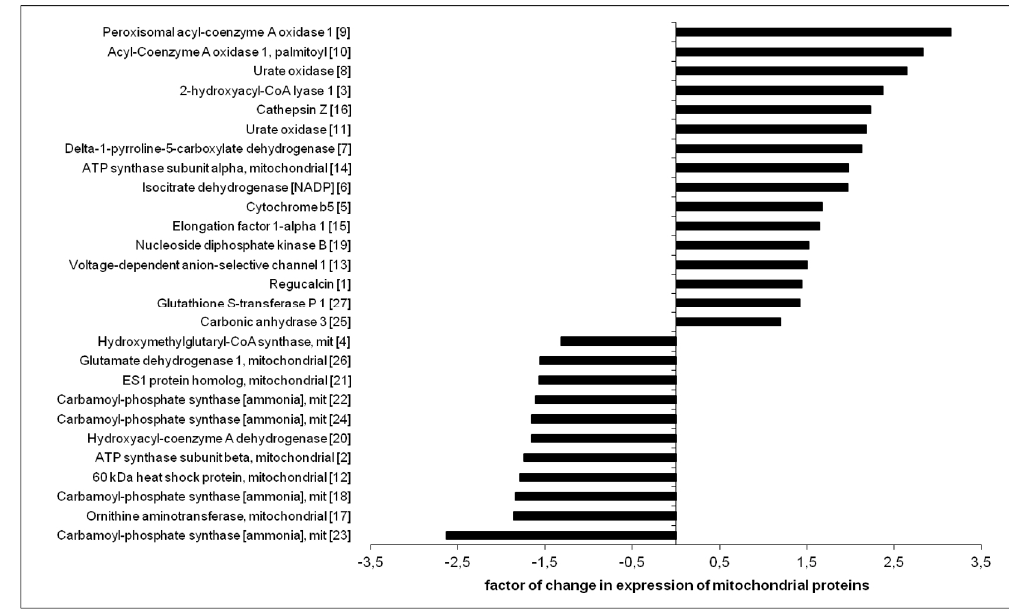
Figure 5. Relative changes in expression of mitochondrial proteins in agmatine-treated apoE-/- mice, compared to control apoE-/- mitochondria. Corresponding spot numbers are shown in brackets ( n = 3 per group).